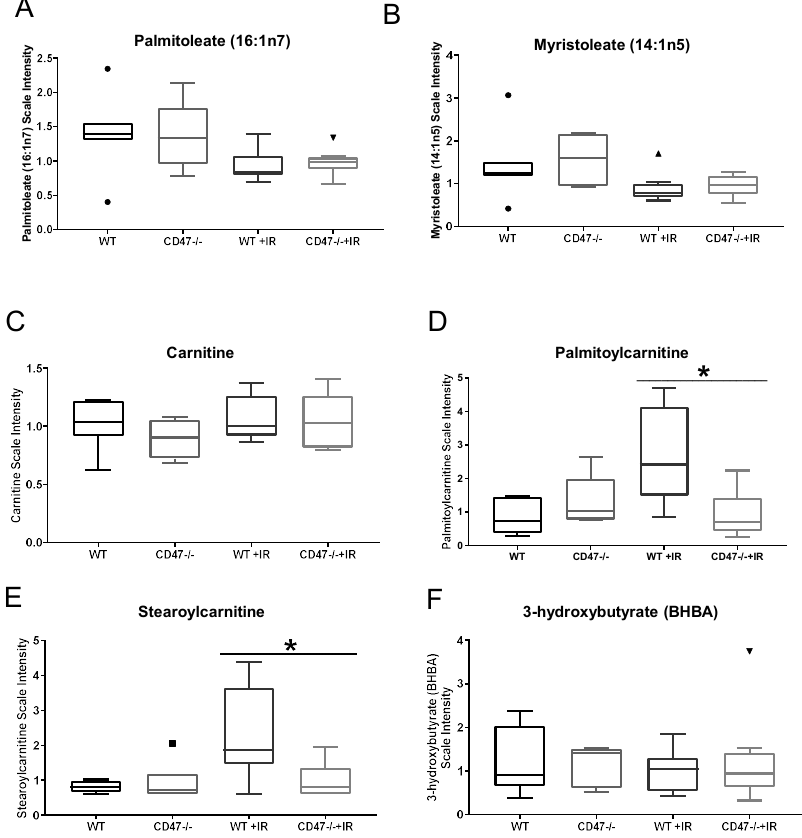
Figure 3. Regulation of lipid metabolism in lungs as a response to ionizing radiation. Lipid metabolites ( A ) Palmitoleate, ( B ) Myriostoleate, ( C ) Carnitine, ( D ) Palmitocarnitine, ( E ) Stearoylcarninitne and ( F ) BHBA of lung tissues were measured 24 h after exposure to whole body irradiation. Symbols denote outliers. (* p < 0.05, n = 7–8).